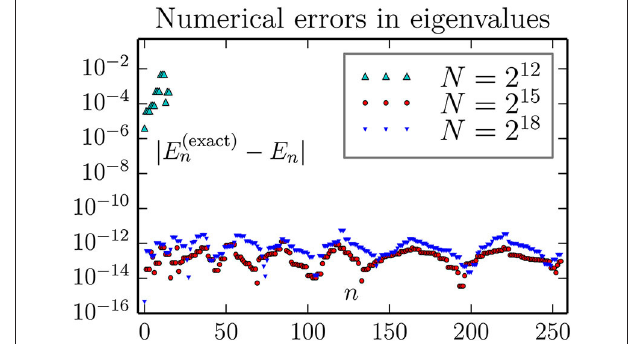
FIGURE 9 | Accuracy of computed eigenvalues for a 1 D oscillator, using the FFT approximation for kinetic energy T . This figure may suggest that an increase in the number of lattice size N will lead to a accurate treatment of states with higher n . Our findings are that this is not the case: The results for N 2 7 and N 2 8 have essentially the same behavior as for N = =